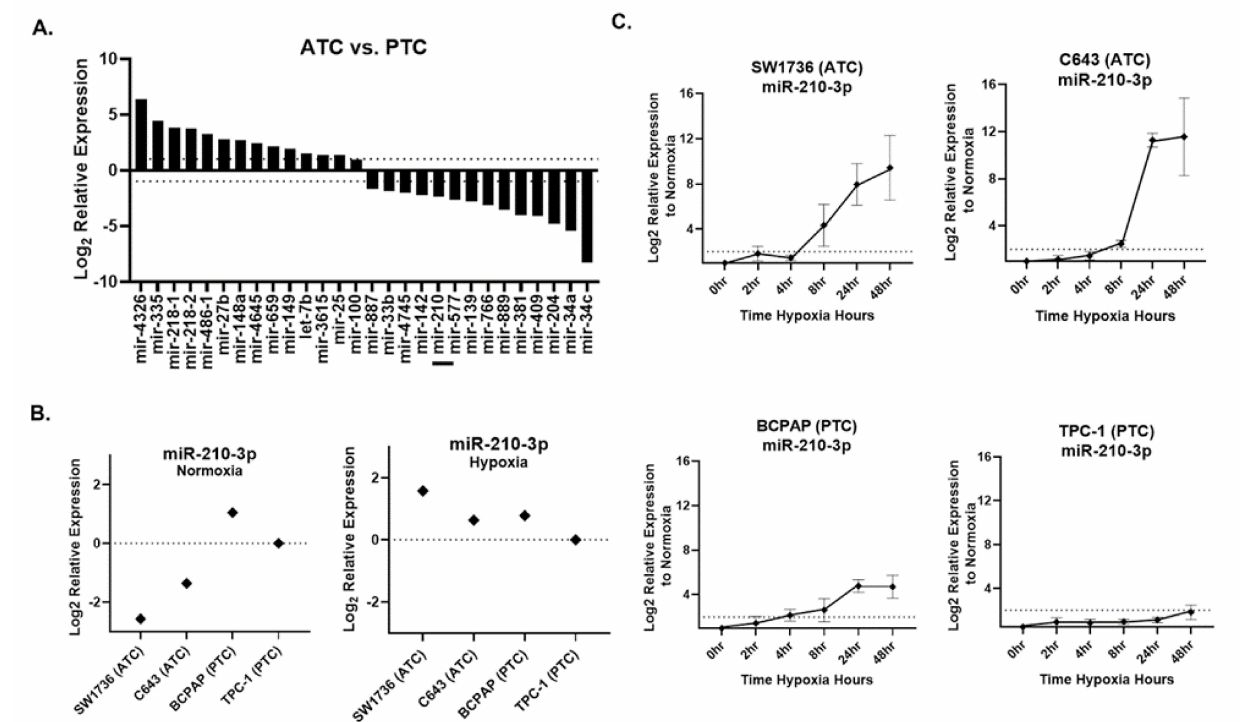
Figure 2. miR-210 expression in ATC and PTC cell lines. ( A ). The RNA-seq analysis of differentially expressed pre-miRNAs between anaplastic thyroid cancer (ATC) cell lines SW1736 and C643 and papillary thyroid cancer (PTC) cell lines BCPAP and TPC-1. Log 2 fold change > ± 1. q value < 0.05 n = 3. Bar included to highlight miR-210. ( B ). RT-qPCR of miR-210 basal expression and hypoxia (2%O 2 )-induced expression in ATC vs. PTC cell lines. ( C ). The ATC vs. PTC qPCR analysis